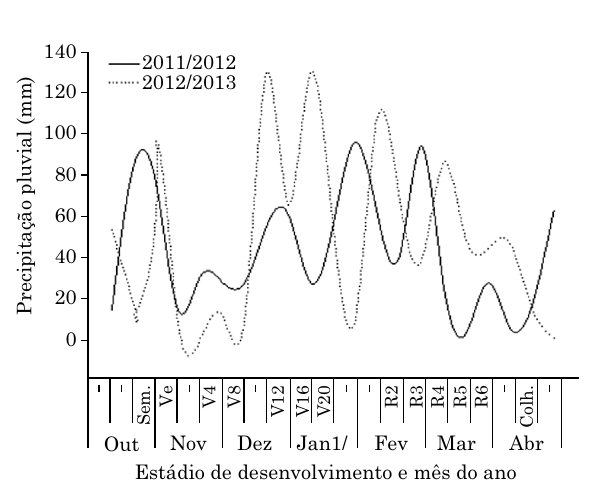
Figura 1. precipitação pluvial e estádios fenológicos do milho nos anos agrícolas 2011/2012 e 2012/2013, em lages,